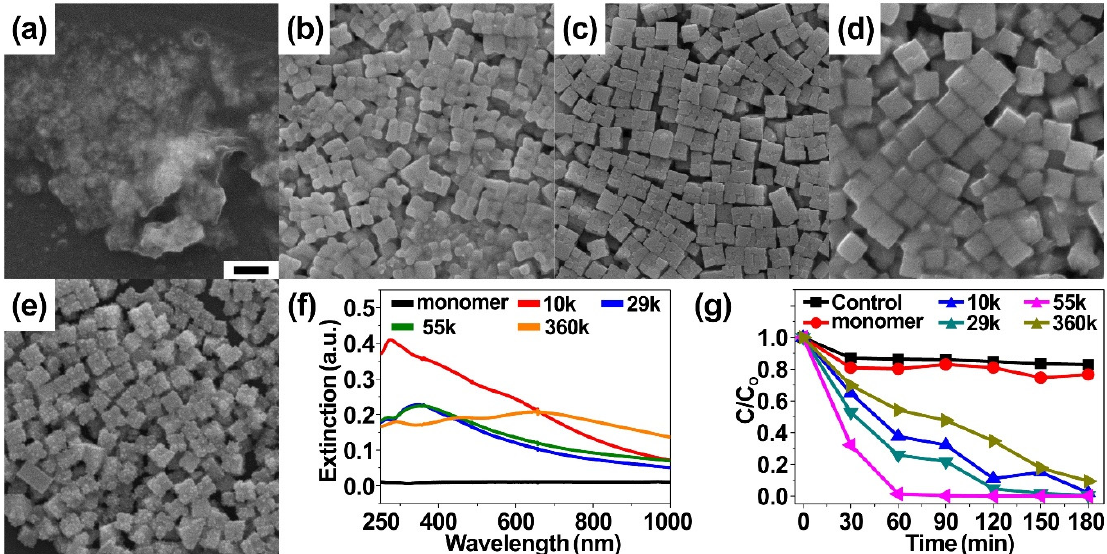
Figure 3. ( a – e ) SEM images of the cubic AgCl@AgAu NPs with PVP having di ff erent MWs. ( a ) Monomeric vinyl pyrrolidone, ( b ) 10,000 (10k), ( c ) 29,000 (29k), ( d ) 55,000 (55k), and ( e ) 360,000 (360k). ( f ) UV-vis spectra of the cubic AgCl@AgAu NPs synthesized with PVP having di ff erent MWs. ( g ) Time-dependent photocatalytic degradation of amaranth with the cubic AgCl@AgAu NPs synthesized with PVP having di ff erent MWs.